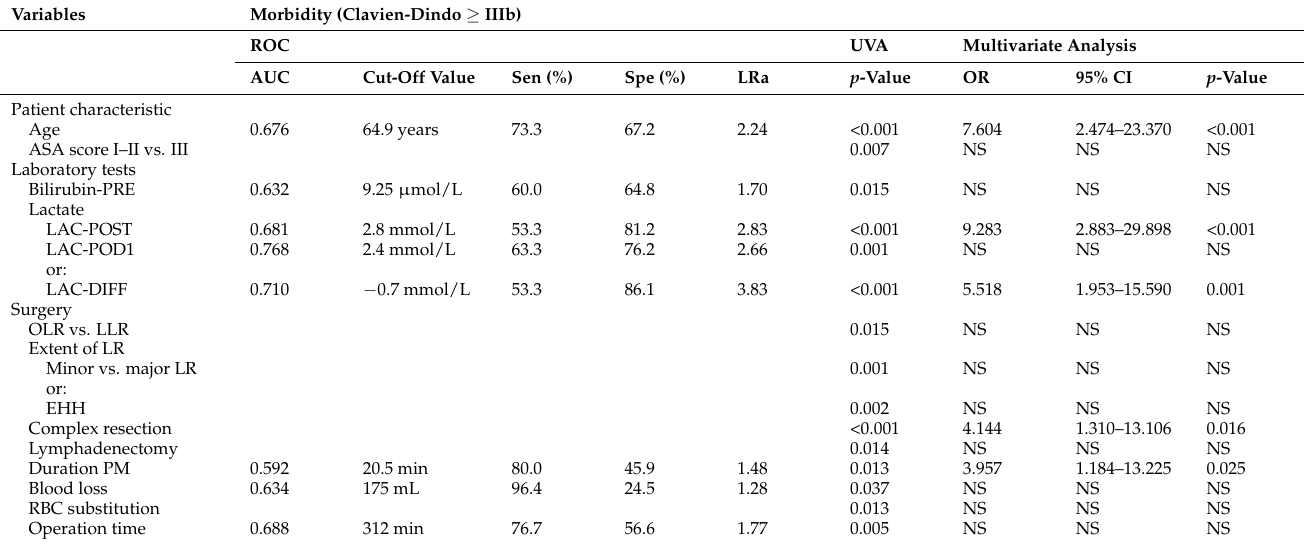
Table 4. Predictors of postoperative morbidity in 152 patients who underwent liver resection.